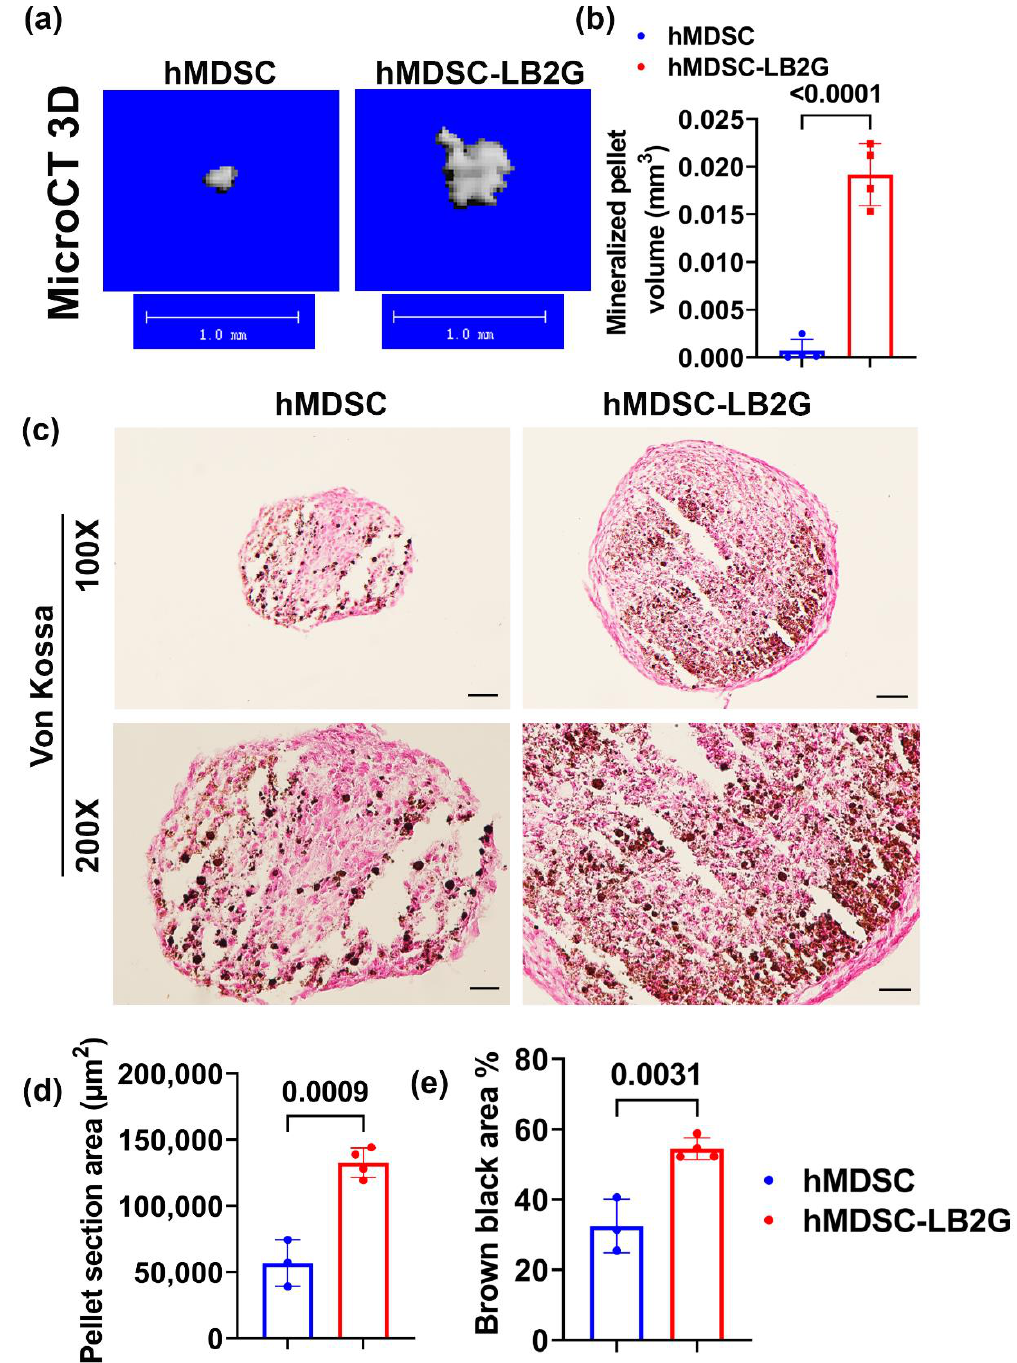
Figure 1. In vitro osteogenesis of lenti-BMP2/GFP-transduced hMDSCs compared to non-transduced hMDSCS. ( a ) MicroCT 3D images of osteogenic pellets at day 28. Lenti-BMP4/GFP-transduced hMDSC formed larger mineralized pellets. Scale bars = 1 mm. ( b ) Quantification of mineralized pellet volume. ( c ) Von Kossa staining showed bigger pellets and higher percentage of brown-black mineralization in lenti-BMP2/GFP-transduced hMDSCs than non-transduced hMDSCs. Scale bars = 100 µm for 100× images and 200 µm for 200× images. ( d , e ) Quantification of Von Kossa staining (100×) for pellet section area and brown-black calcium deposit percentage.